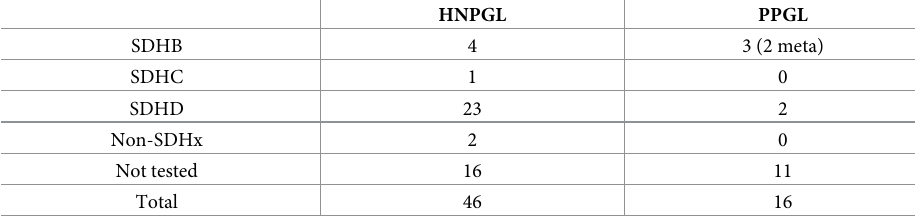
Table 1. Summary of the gene variants found in this study. Abbreviations: SDHB, C & D, succinate dehydrogenase subunits B, C & D, respectively; HNPGL, head & neck paraganglioma; PPGL, pheochromocytoma-sympathetic para- ganglioma; meta,